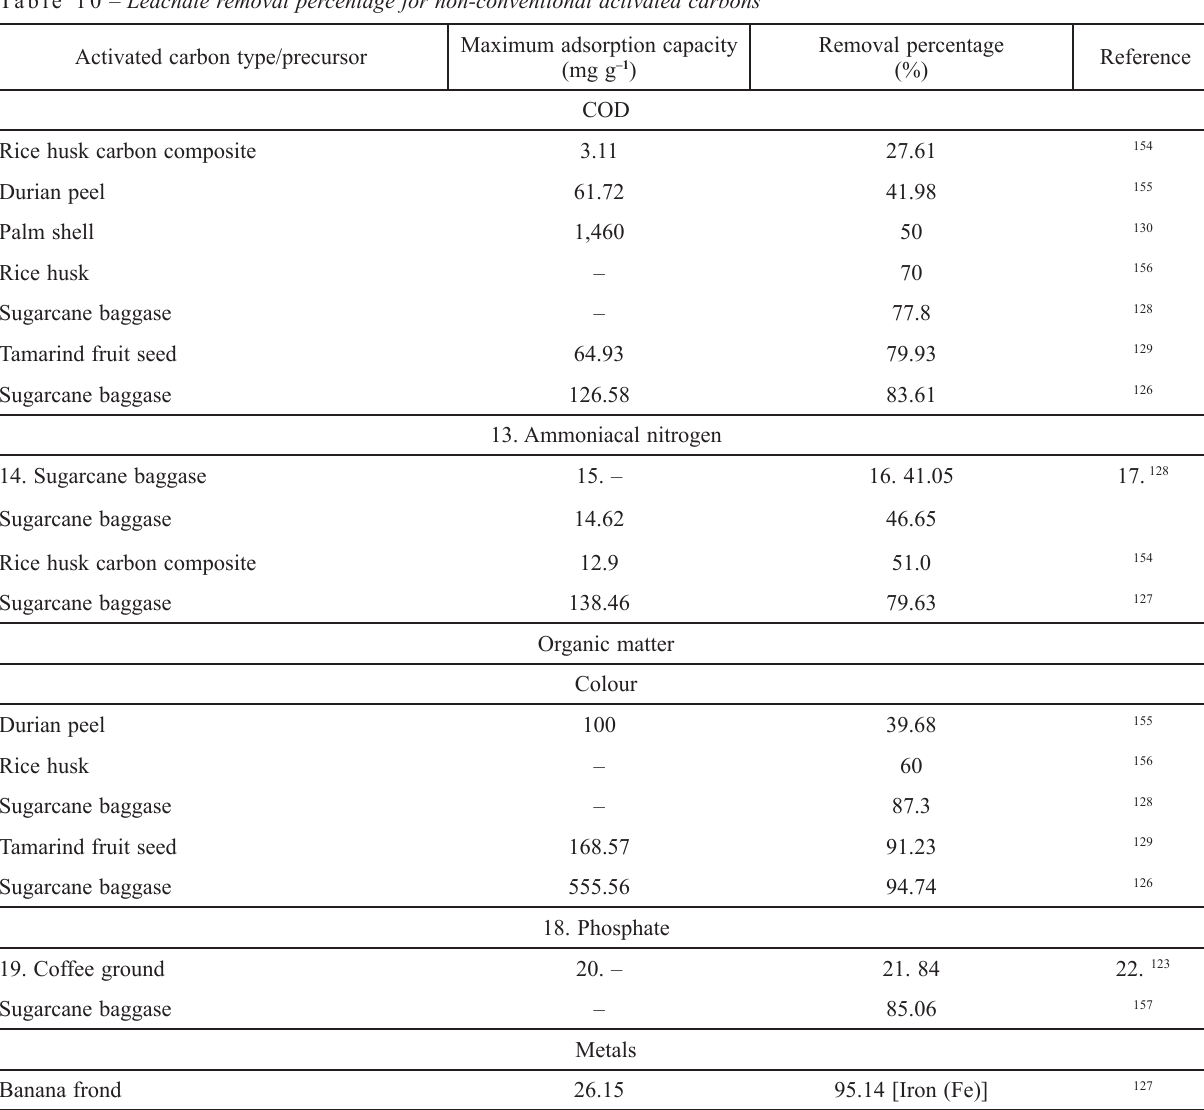
Table 10 – Leachate removal percentage for non-conventional activated carbons Activated carbon